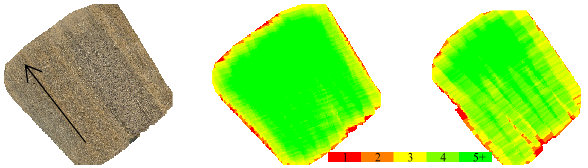
Figure 3. Ortho mosaic (1) and image overlap [nbr. of images] with Panasonic Lumix (2) and Sony NEX (3) in Andalusia. Arrow indicates direction of increasing height above terrain. Point density is differing between TLS and UAV data and between small and large study site (Table 2). Especially PhotoScan exhibits for the DTMs generated from UAV images high point densities up to six points per square centimetre. For the UAV data point density decreases with decreasing ground resolution due to higher flying heights. In contrast, point density of TLS data is decreasing with increasing distance to the scanner position and consequently is lowest in the middle of the study site, which is even more relevant for the larger plot in Andalusia.